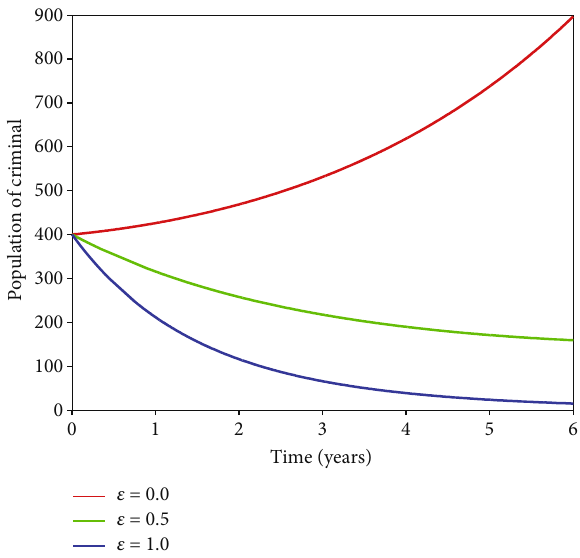
Figure 4: Simulation result showing the impact of vocational training on criminal population.